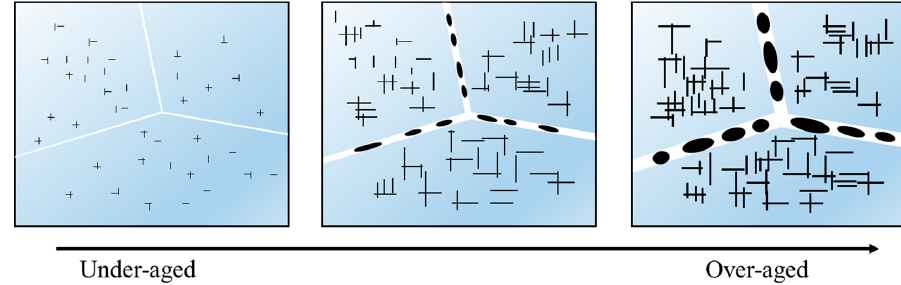
Figure 10. Schematic diagram of microstructure evolution.